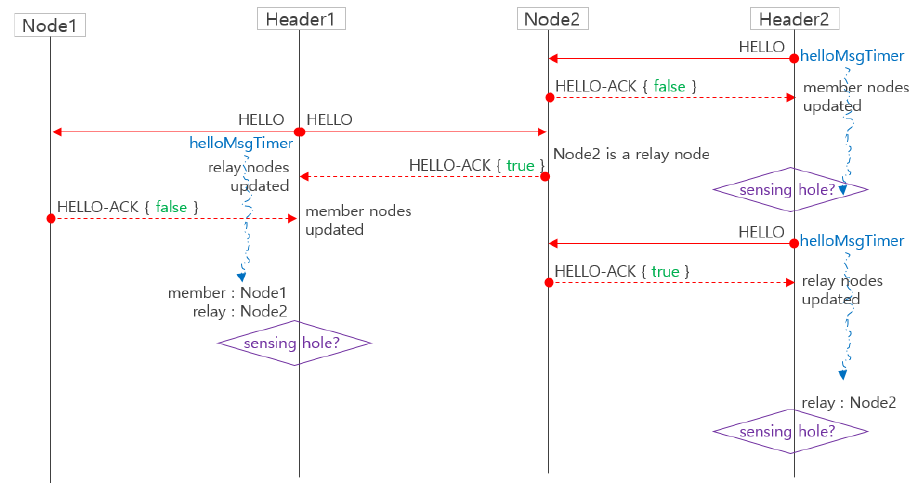
Figure 7. The managing members and relay nodes in cluster headers.